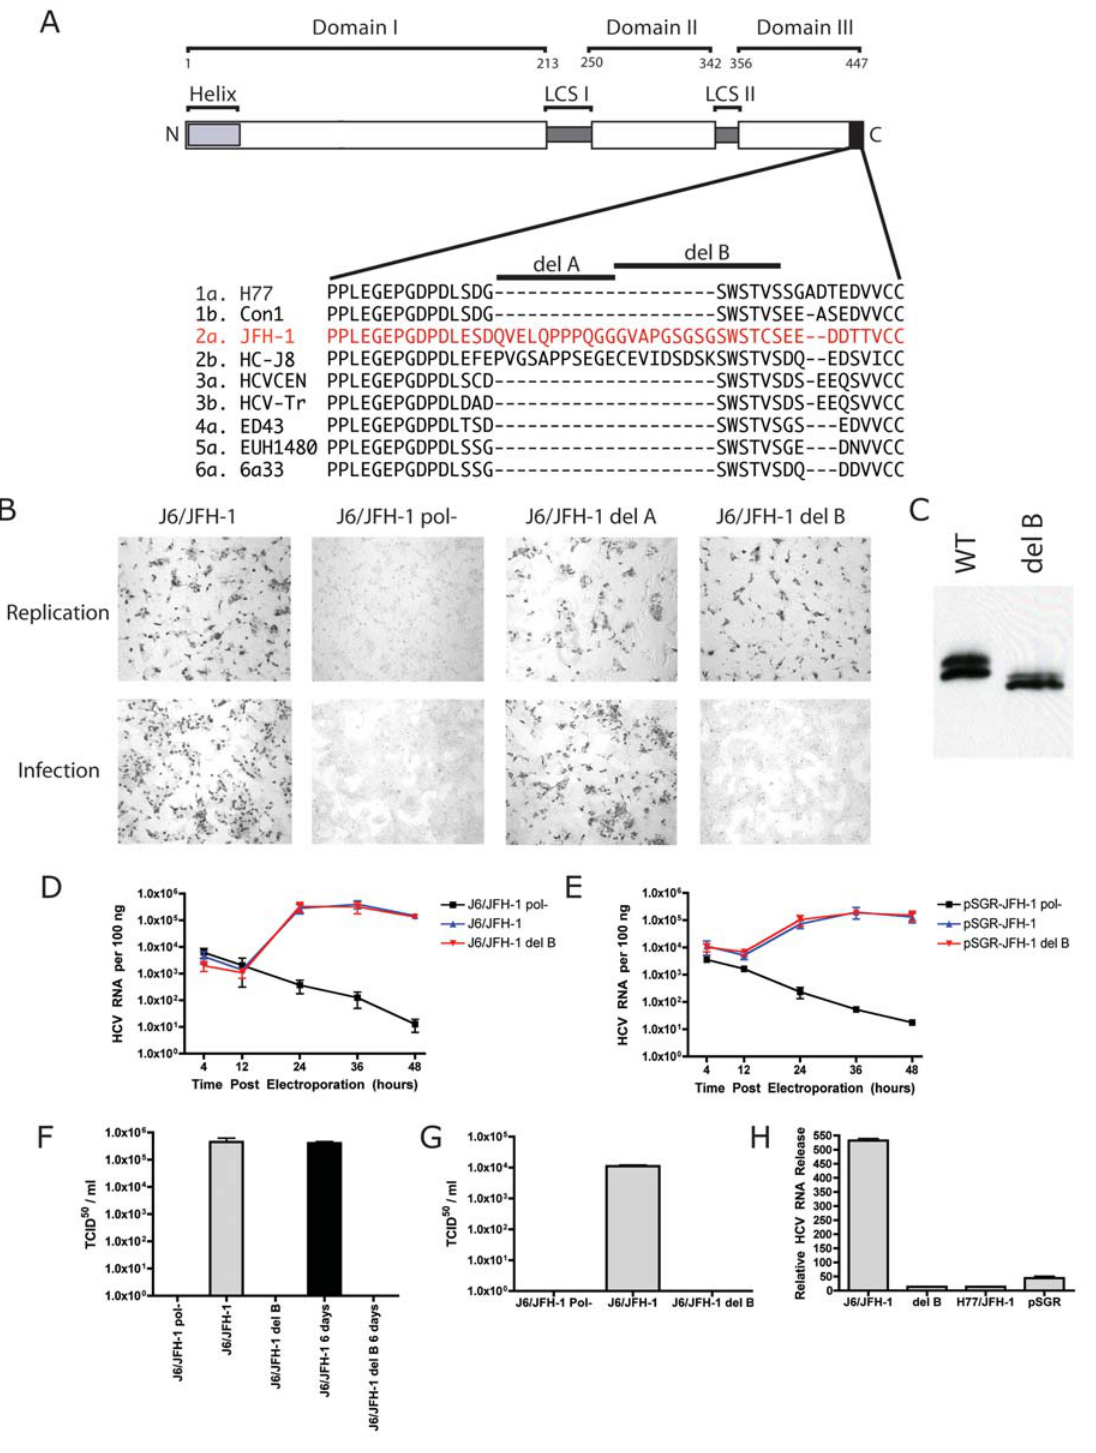
Figure 1. A Deletion in NS5A Domain III Disrupts the Production of Infectious Virus. A). Schematic representation of the domain organization of NS5A indicating the locations of the three domains and low complexity domain connectors (LCS). The location of the membrane anchoring helix is also shown. Numbers indicate amino acid positions on the Con1 genotype 1b NS5A sequence. Sequences of the C terminus of NS5A indicated by the black box on the schematic are shown below for representative sequences of major HCV genotypes. The sequences shown are 1a H77 (AF011753), 1b Con1 (AJ238799), 2a JFH-1 (AB047639), 2b HC-J8 (D10988), 3a HCVCEN (X76918), 4a ED43 (Y11604), 5a EUH1480 (Y13184), and 6a 6a33 (AY859526). B). IHC analysis of cells electroporated with indicated viral RNAs (top of image rows) for NS5A 48 hours post electroporation (top row of panels) or 48 hours post infection (bottom row of panels). C). Western blot of wild type (WT) and deletion B (del B) NS5A from cells electroporated with replication competent full-length genomes shown in B and D. D). RNA replication 48 hour time course of J6/JFH-1 (blue line), J6/ JFH-1 deletion B (red line), or J6/JFH-1 pol- (black line) as determined by real time PCR analysis. E). RNA replication 48 hour time course of indicated